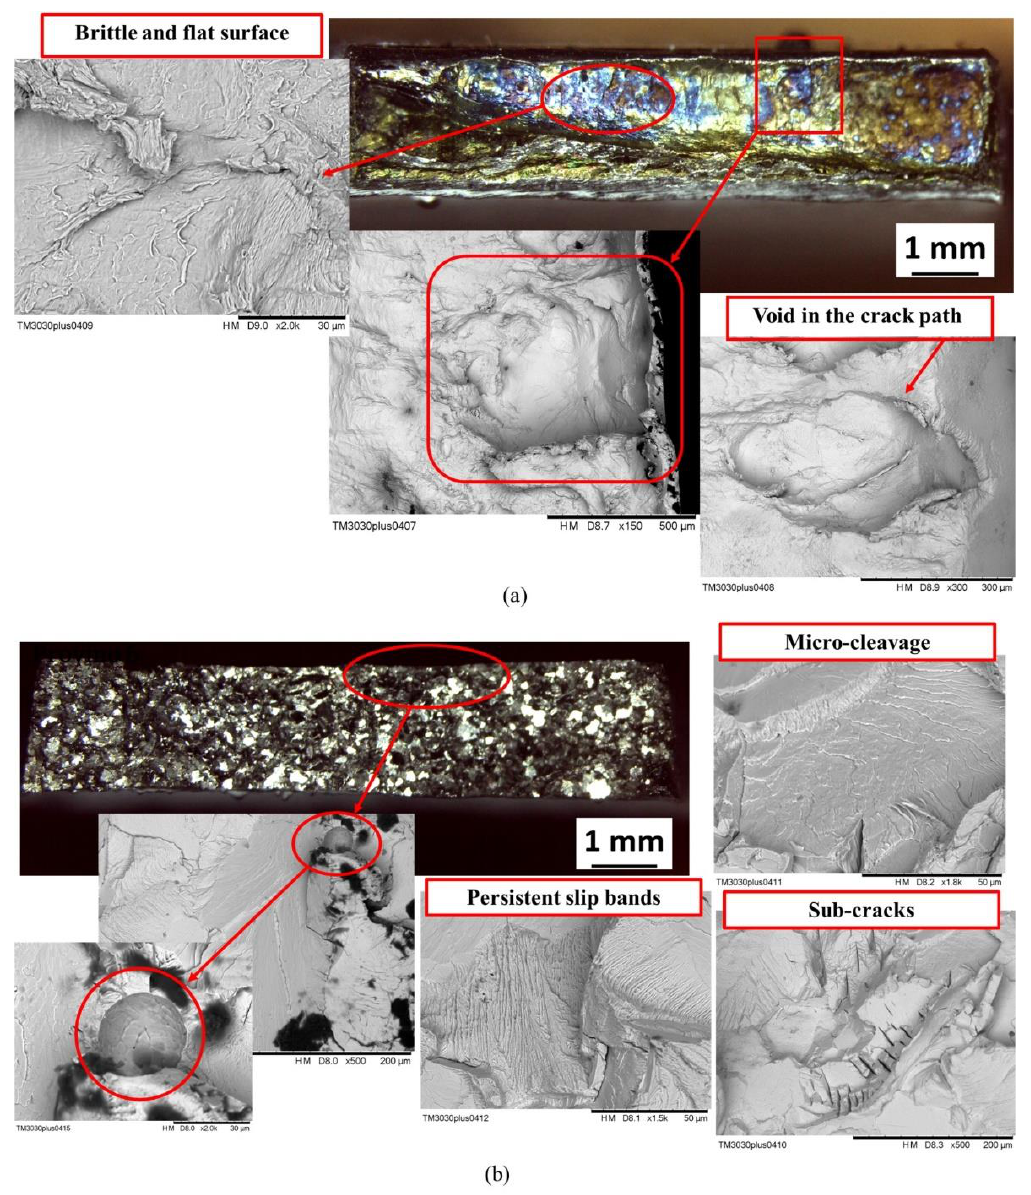
Figure 12. Fracture surfaces of the specimens tested at ∆ σ = 200 MPa: ( a ) Failure at 440,740 cycles (specimen 6); ( b ) failure at 192,951 cycles (specimen 7).